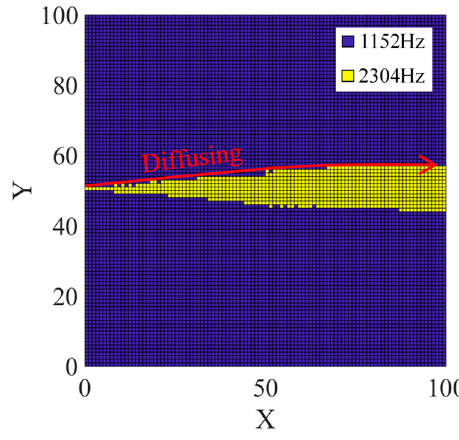
Figure 14. The distribution of dominant frequencies f vs and 2 f vs .